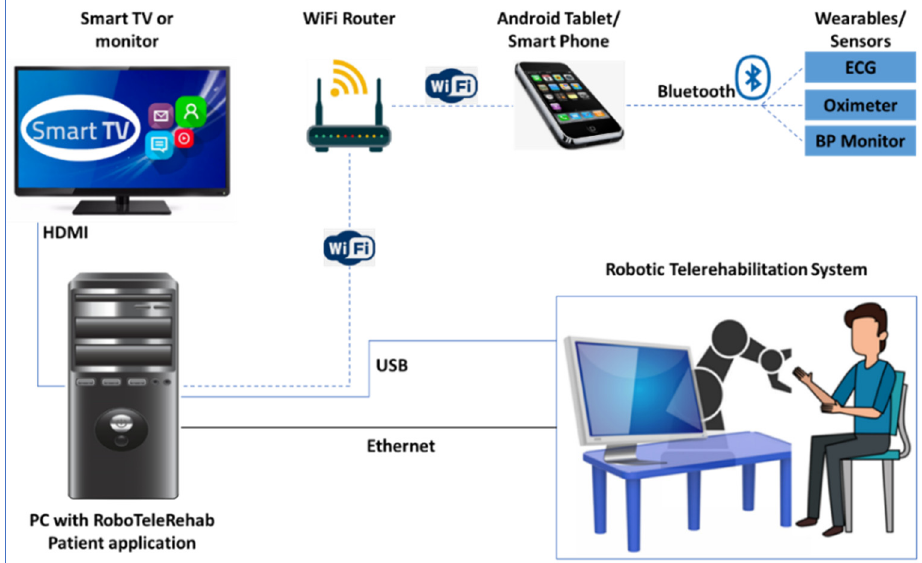
Figure 5. RoboTeleRehab patient hardware.